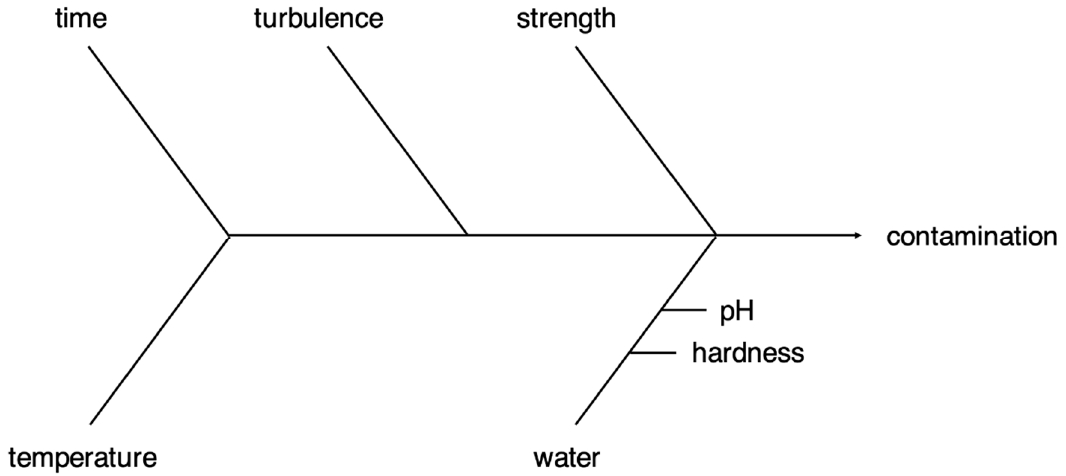
Figure 3. Ishikawa diagram of causal influences of extraction on cold brew coffee contamination.